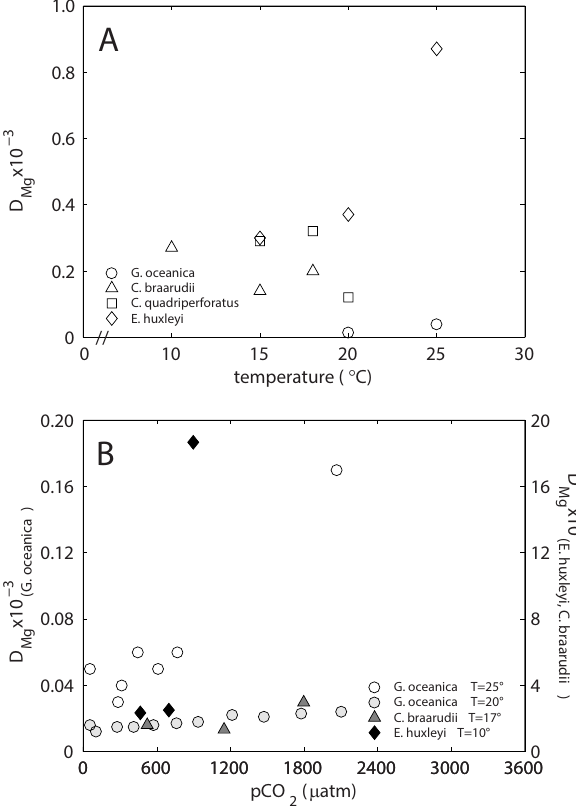
Fig. 2. Magnesium partition coefficient ( D Mg ) as a function of (A) temperature ( p CO 2 = 370 ± 70µatm) and (B) p CO 2 (temper- ature as indicated). In (B) markers of E. huxleyi and C. braarudii are related to the y axis on the right. Please note that G. oceanica experienced nutrient limitation at 25 ◦ C (see text for